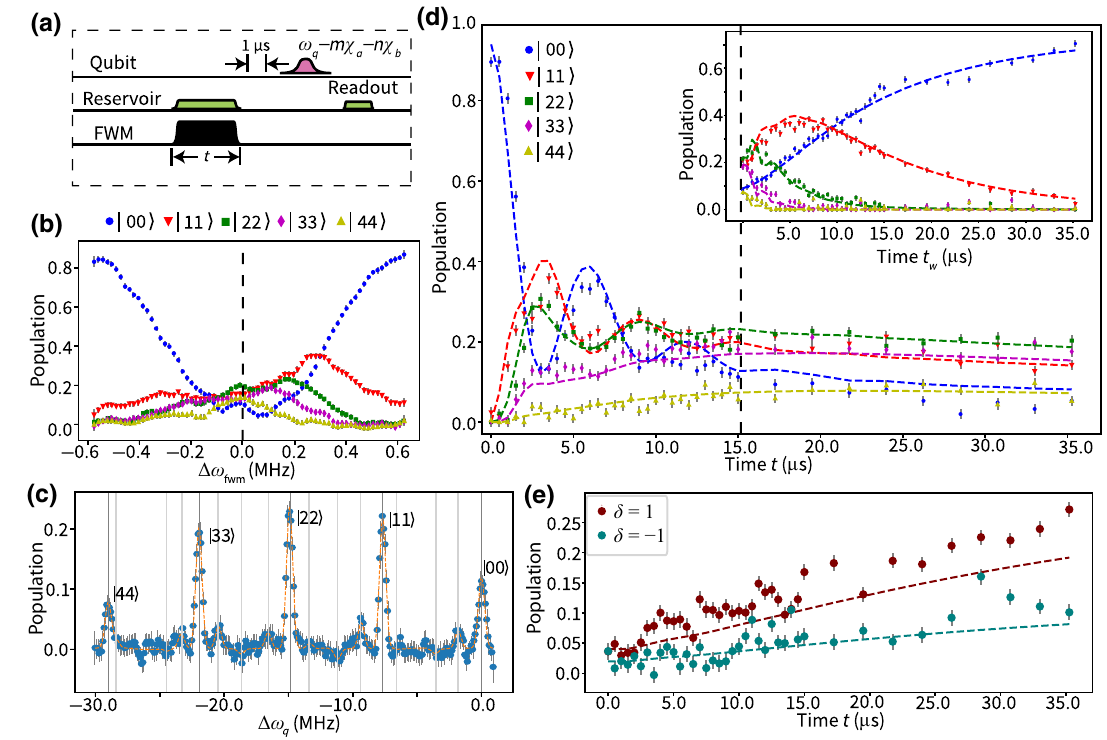
FIG. 2. PCS characterization: the population and time dynamics. (a) A pulse sequence using selective ancilla rotation to analyze the photon population dynamics. We use an ancilla π pulse with a frequency as shown to measure the population of a two-cavity state | mn (cid:2) after waiting for 1 µ s for the reservoir to relax. (b) The populations of two-cavity states | 00 (cid:2) through | 44 (cid:2) after pumping a vacuum state for t = 15 µ s at different FWM pump frequencies (while keeping the reservoir drive constant). The remaining experiments are carried out under the condition shown as (cid:7)ω fwm = 0 here. (c) Transmon spectroscopy after 15 µ s of pumping with cw FWM and reservoir tones. The dark vertical lines correspond to δ = 0 states while the light vertical lines correspond to error states caused by single-photon loss. (d) Time-domain photon population measurements with both cw tones applied for a variable time t . The inset shows a time-domain measurement of the pair-photon decay (without pair-photon drives) by keeping only the FWM pump on for a variable amount of time after the two-tone pumping for t = 15 µ s (vertical dashed line). The dashed curves are numerical fits to the pair-photon dynamics model [see Eq. (8)] plus single-photon losses, including only two free parameters: (cid:5) ab / 2 π = 99 kHz and κ ab = ( 12.7 µ s ) − 1 . (e) Measurement of the photon-number difference δ , where the probability of δ = ± 1 is measured over variable time t to show the effects of single-photon loss from the storage cavities. The nonzero initial populations are due to imperfect cavity reset. The dashed lines are simulation results with the same parameters as in (d). Note that all population values are inferred from a normalized readout procedure (applies to all figures), as discussed in Appendix